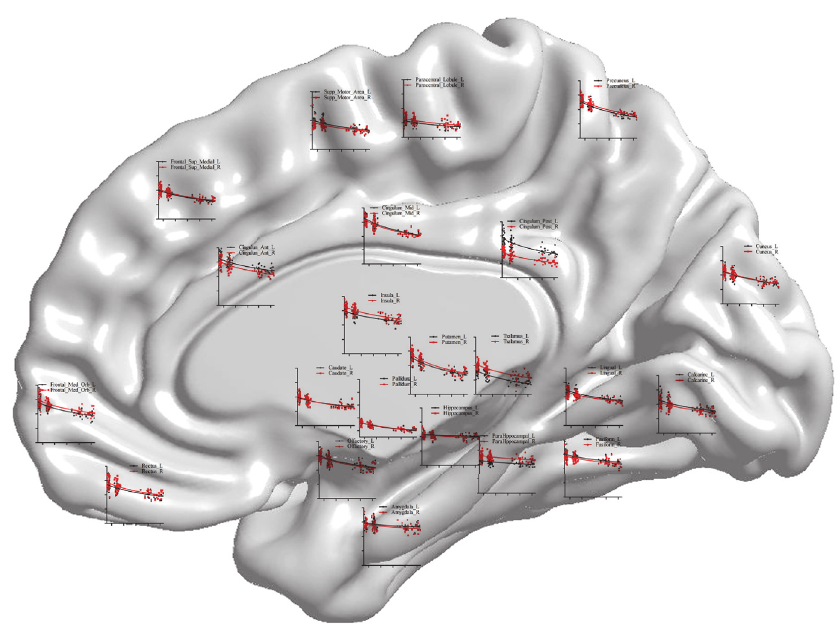
Figure 4: Scatterplot map of the subcortical regions. Shown is a surface rendering of a human brain with scatterplots for GMV at various anatomical points over the subcortical regions where the measurements were taken. Age in months is represented on the x -axis (range 50 to 300) and GMV on the y -axis (range 0.2 to 1.0). Red lines represent left hemisphere and black lines represent right